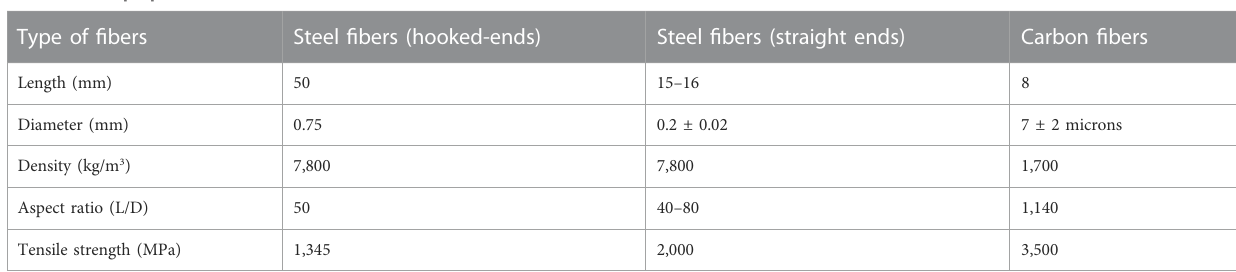
TABLE 1 Fiber properties. Type of fi